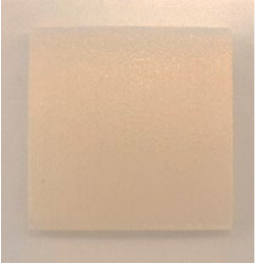
Figure 1. 3D printed photopolymer substrate.